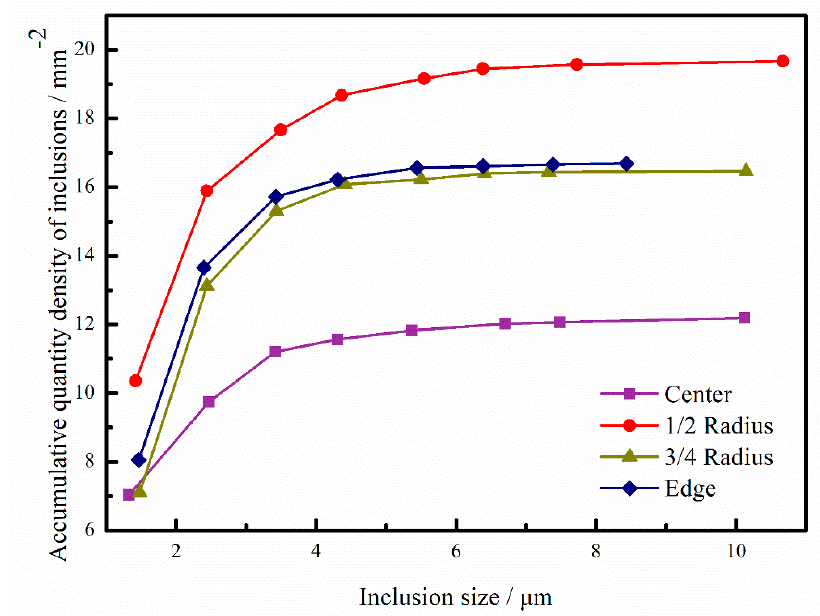
ff erent sizes of sulfide